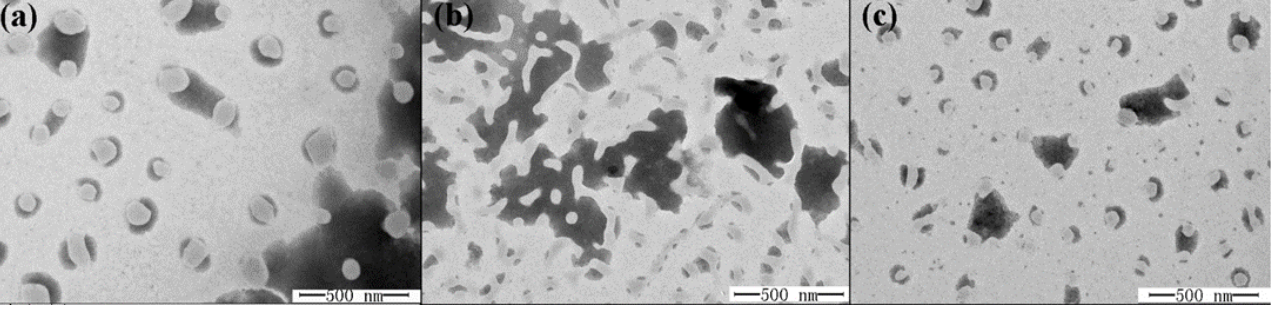
Figure 4. TEM images show nanoemulsions prepared with sample F5 ( a ), F6 ( b ), and F7 ( c ).